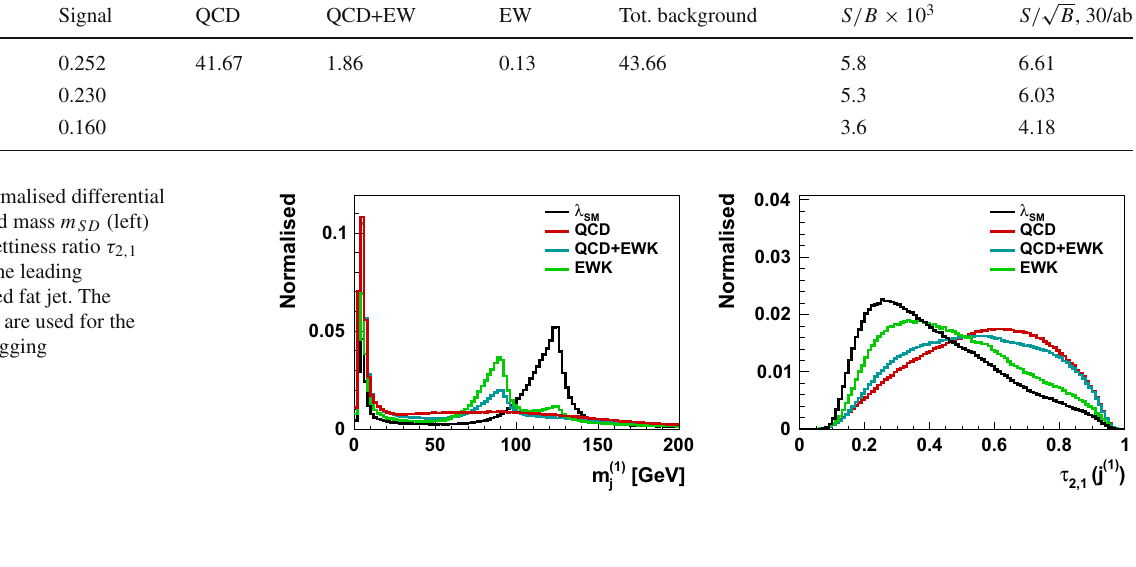
Table 8 Results for the fully-resolved 4 b -jet analysis of pp → hhj , Sect.3.Weincluderesultsforthreedifferentchoicesoftheself-coupling within the κ framework [64], κ λ = λ/λ SM ; BDT training is performed